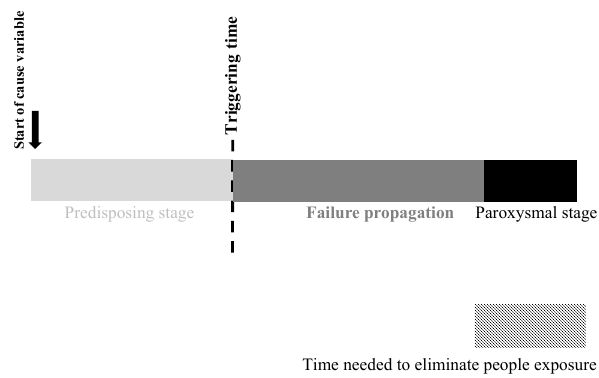
Figure 1. Evolutionary stages of a collapse